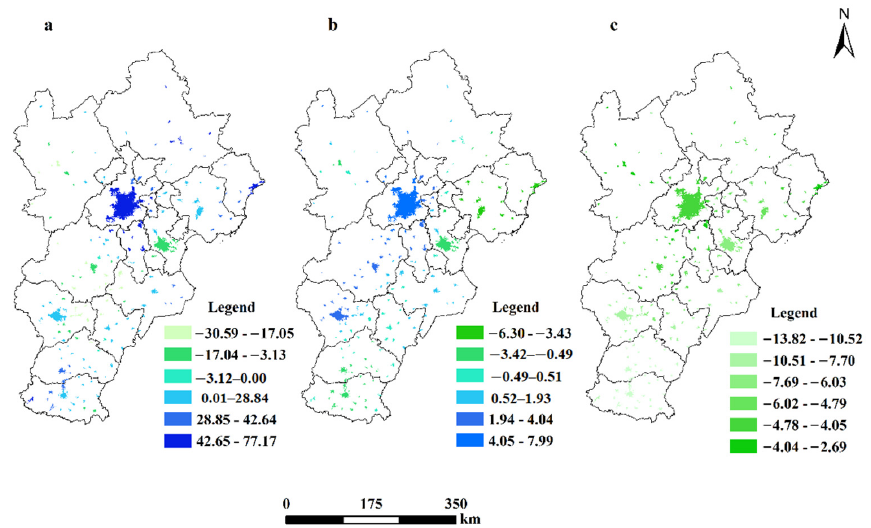
Figure 6. Variations in precipitation in the Beijing–Tianjin–Hebei urban agglomeration from 2000 to 2018 ( a ), summer; ( b ), winter; ( c ), annual; green or light green means decrease, blue or light blue means increase; units: mm).